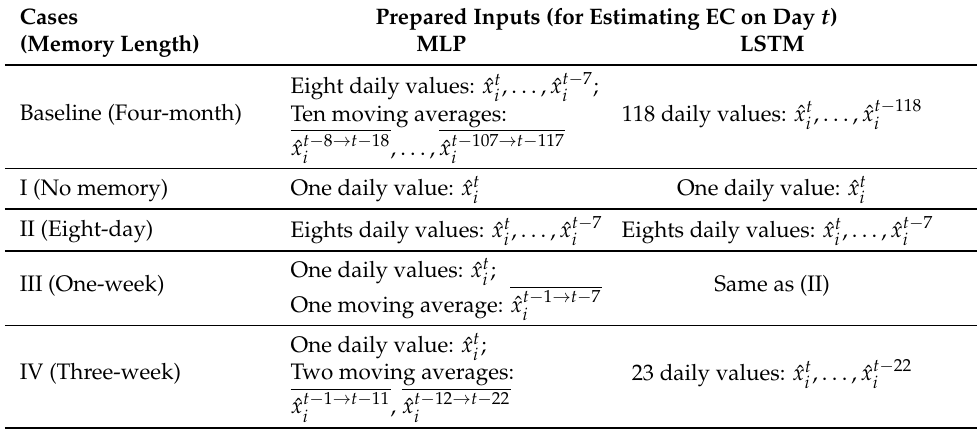
Table 1. Arrangement of pre-processed inputs for each